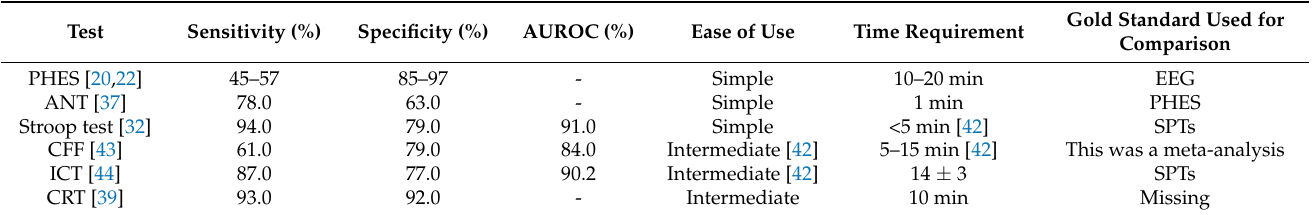
Table 2. Characteristics of the most frequently used diagnostic methods for minimal hepatic